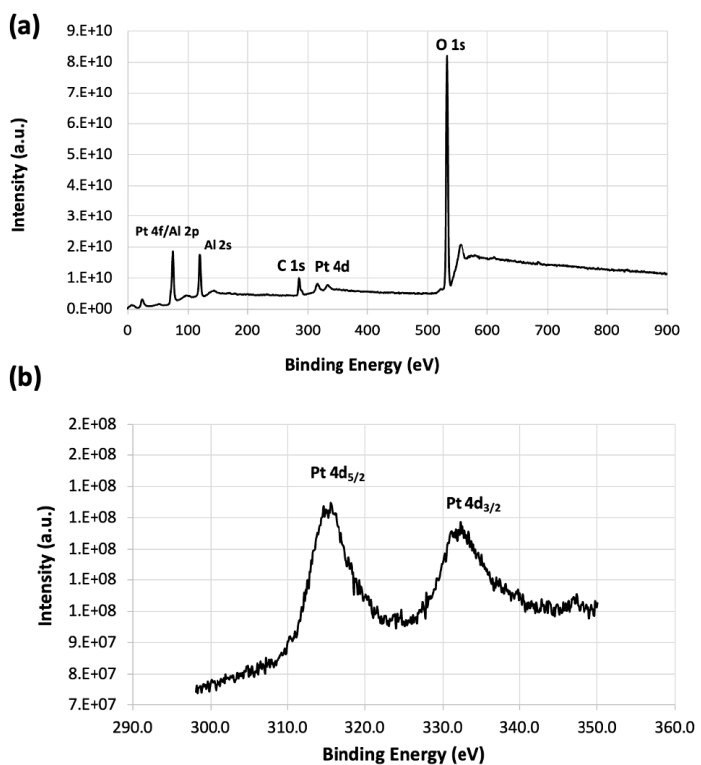
Figure A2. SEM images of SD microparticles synthesized using 0.4Pt@PS with PS sizes of 385.6 nm at different SD slurry concentrations. ( a ) 10 wt.%; ( b ) 15 wt.%; ( c ) 20 wt.%. Microparticles with ≤ 2 µm diameter have spherical shape as demonstrated on zoomed in images on the right.